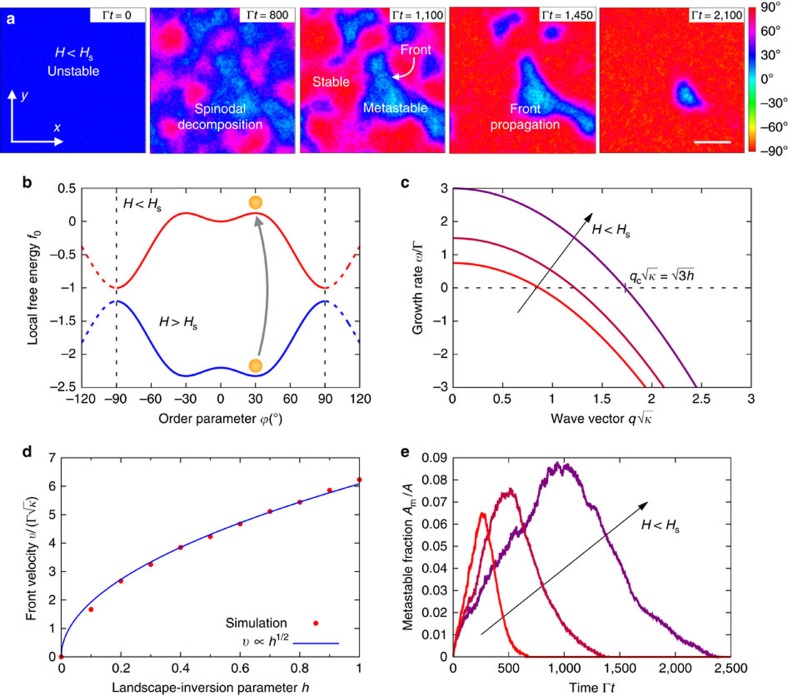
Formation of a metastable phase by spinodal decomposition and front propagation.(a) Simulation snapshots of the phase-ordering process resulting from a quench from H>Hs to H<Hs (see Supplementary Movie 1). Colour indicates the order parameter field (r, t) of the model. The system, initially at the unstable state =30° (dark blue), undergoes an asymmetric spinodal decomposition that spontaneously generates both stable =90° (red) and metastable =0° (light blue) domains. The latter are subsequently invaded by the former via propagating fronts. Γ−1 and  define the time and length units in the simulations, respectively. Scale bar, 50. (b) Model energy landscape of the LIPT, equation 2. The dashed part illustrates the periodicity of the potential. (c) Dispersion relation of the unstable state, equation 4, for different values of the magnetic field. The field controls the region of unstable modes q<qc and thus the range of sizes of the forming domains. (d) Velocity of planar fronts as a function of the landscape-inversion parameter h≡1−H2/ from simulations, with a fit of the predicted scaling v∝h1/2. (e) Time evolution of the area fraction covered by the metastable state for different values of the magnetic field. This graph shows the formation and subsequent elimination of the metastable state, with the overall phase transition dynamics controlled by the external magnetic field.